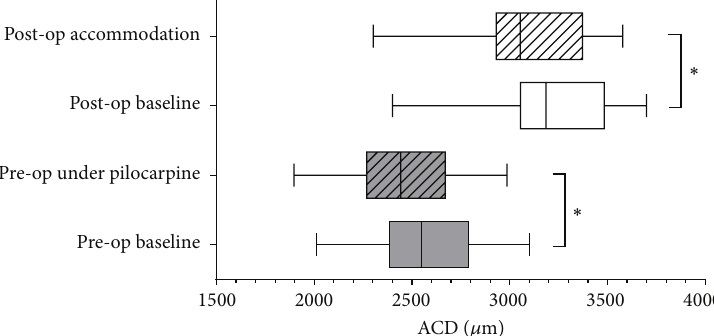
Figure 1: Preoperative lens shifts induced by pilocarpine (LS ) and postoperative intraocular lens shifts under an accommodation stimulus Pilo ) measured with anterior segment optical coherence tomography (AS-OCT). The shift is defined as the Δ -values of the anterior (IOLS Acc = ACD − ACD = ACD − ACD . Pilo: pilocarpine; Acc: accommodation. , and IOLS chamber depths (ACDs): LS Pilo Baseline Pilo Acc Baseline Acc ∗ 𝑃 < 0.05 .